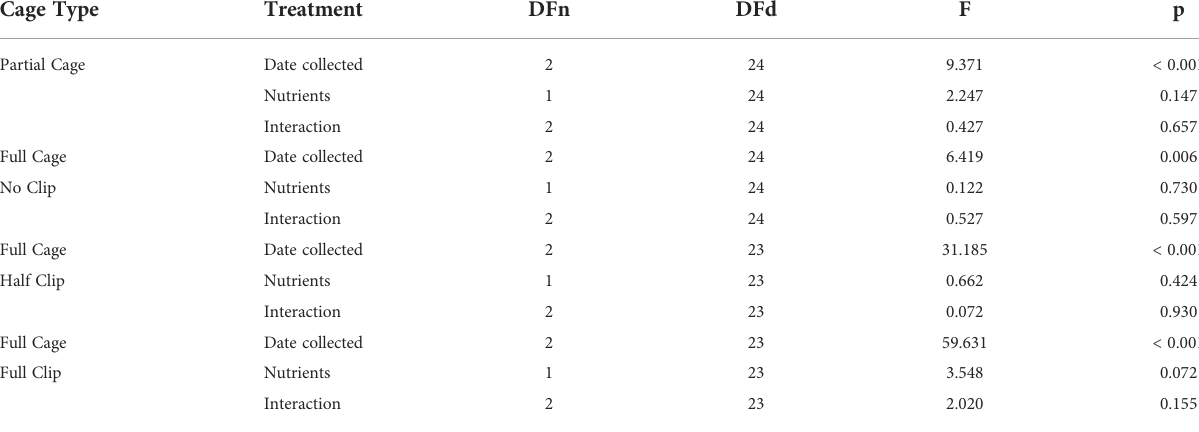
TABLE 2 Results of BACI (Before-After Control-Impact) design on Thalassia testudinum percent cover during a 7-month caging